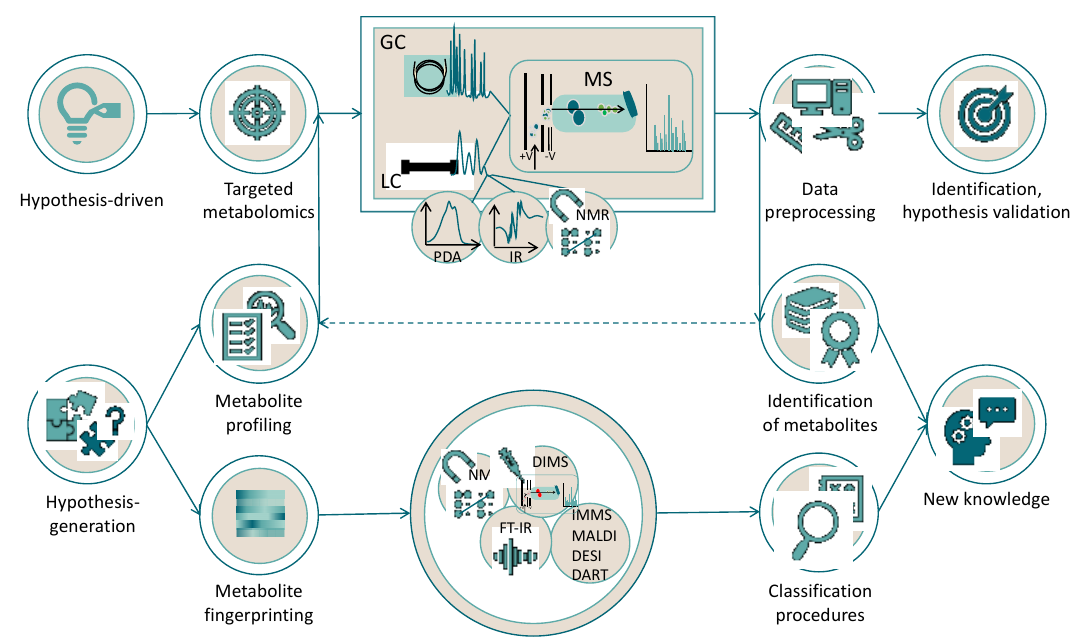
Figure 5. An outlook of the planning of a metabolomics study including the selection of the workflow (hypothesis-driven or hypothesis generation), examples of instrumental techniques, and data preprocessing and interpretation.